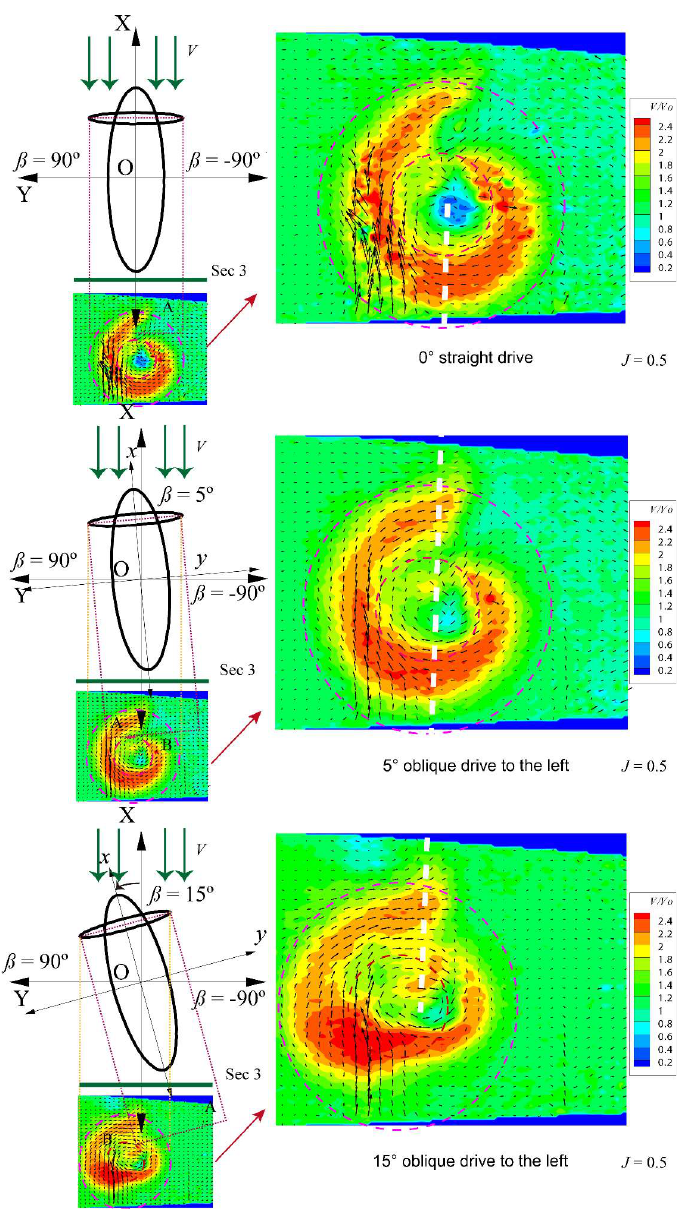
Figure 11. PIV measurements of the L-type podded propulsor at large rudder angles.